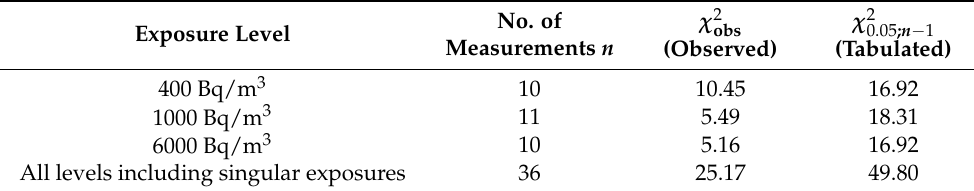
Table 3. Chi-squared consistency check for the different radon levels and for all levels.